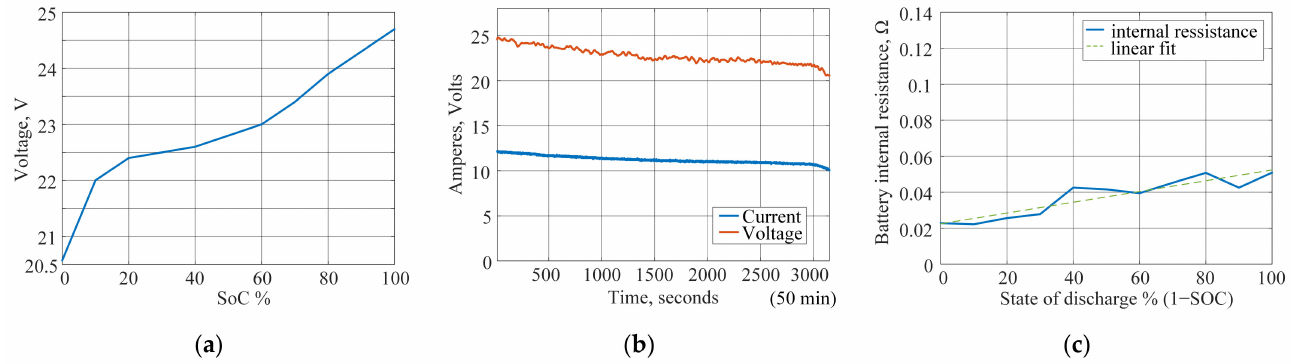
Figure 4. LiPo Battery identification: ( a ) OCV vs. SoC; ( b ) Continuous discharge curve example (2 ohm load); ( c ) Experimentally– recorded and extracted internal resistance vs. state of discharge (1 − SOC), for discharging